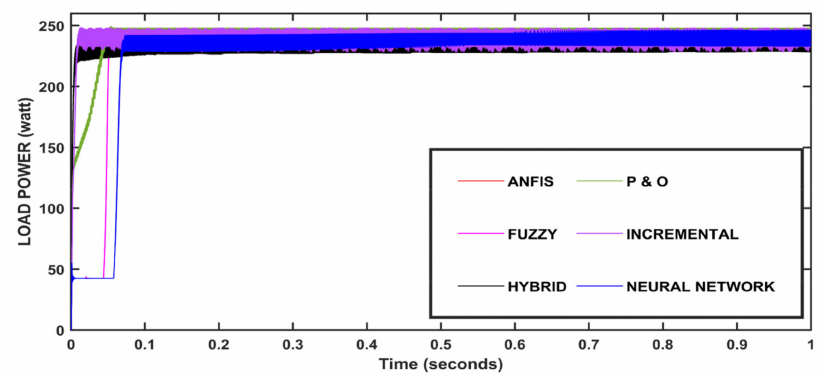
Figure 43. Controllers’ performance for constant irradiance; 1000 W/m 2 , T = 25 ◦ C, load = 30 Ω